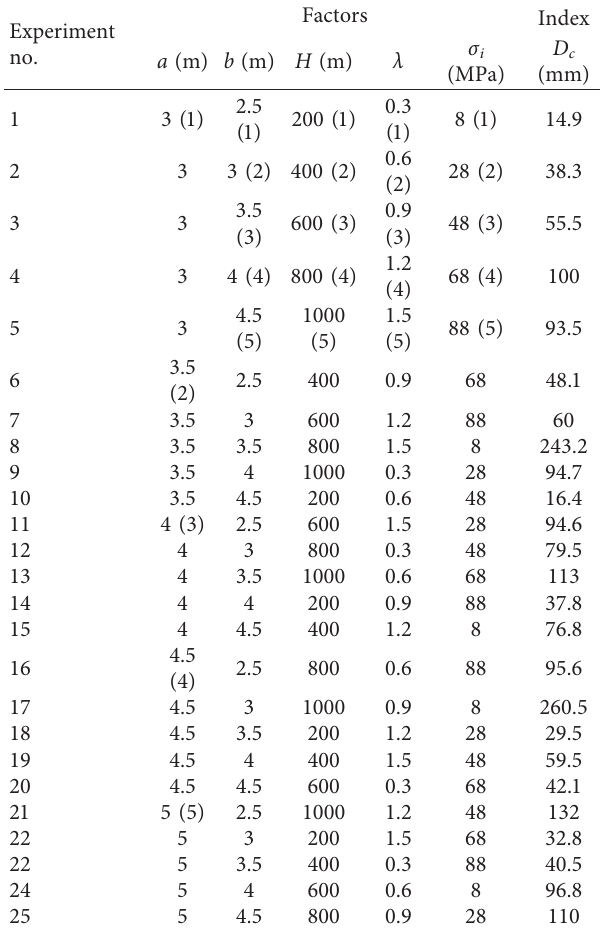
Table 3: The scheme for orthogonal